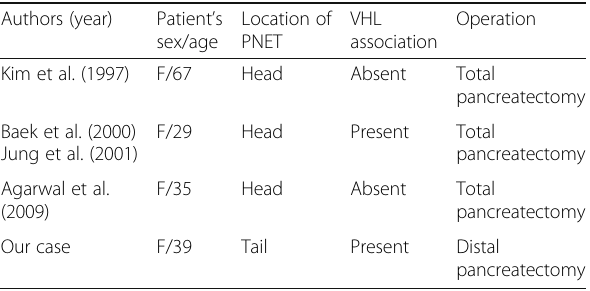
Table 1 Patients with pancreatic neuroendocrine tumor and complete replacement of the pancreas by serous cystic